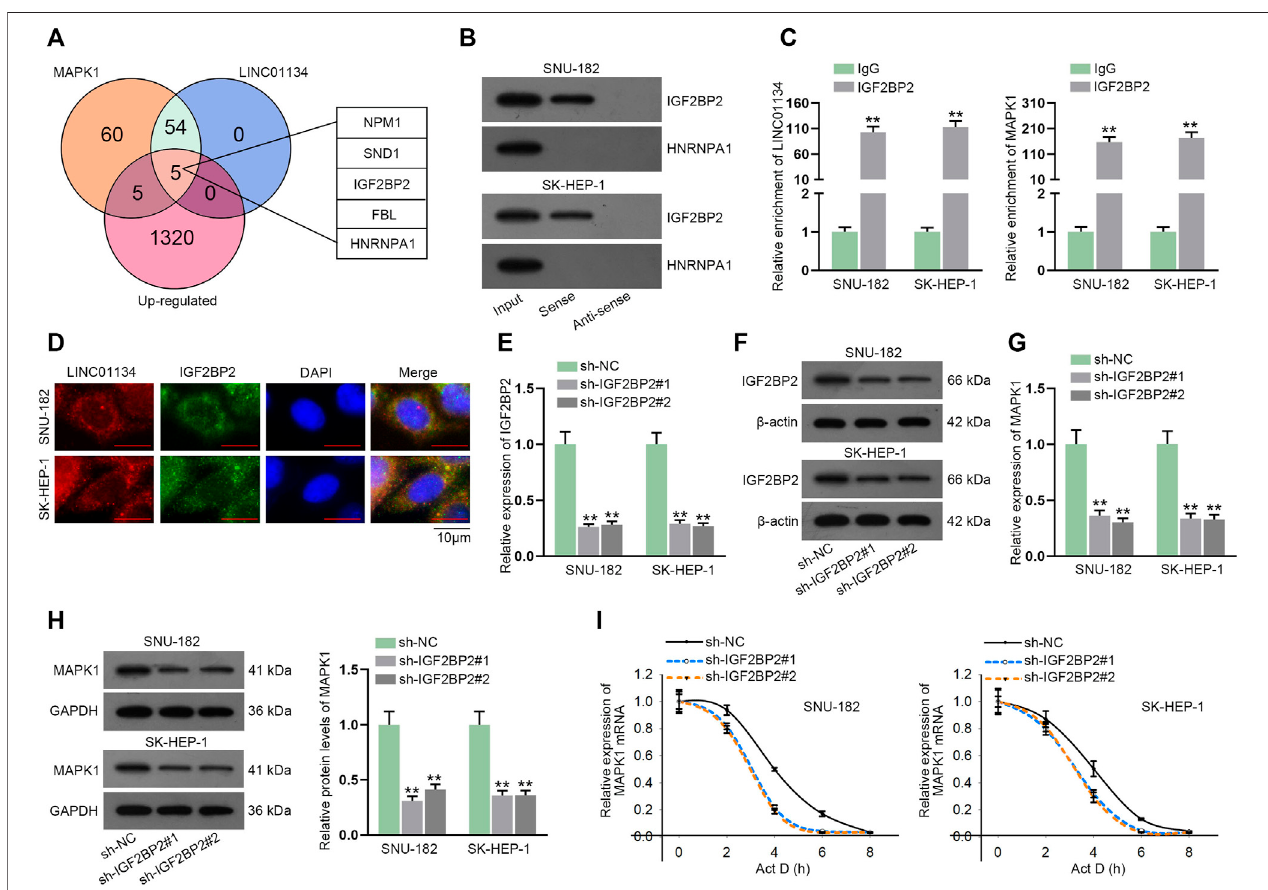
FIGURE 6 | LINC01134 recruits IGF2BP2 protein to stabilize MAPK1 mRNA. (A) The overlap of the Venn diagram demonstrated fi ve common potential RBPs of LINC01134 and MAPK1. (B) RNA pull-down assay was operated to check the af fi nity of LINC01134 with IGF2BP2 or HNRNPA1. (C) RIP assay was implemented to testify the binding between LINC01134/MAPK1 and IGF2BP2. (D) FISH and IF analysis was done to indicate the co-localization of LINC01134 and IGF2BP2 in the cytoplasm of HCC cells (magni fi cation: 1000 × ). (E,F) IGF2BP2 expression was detected through RT-qPCR and western blot assays in SNU-182 and SK-HEP-1 cells upon IGF2BP2 depletion. (G,H) MAPK1 expression was tested after IGF2BP2 was silenced. (I) The stability of MAPK1 mRNA was checked by RT-qPCR when IGF2BP2 was downregulated. ** p < 0.01.